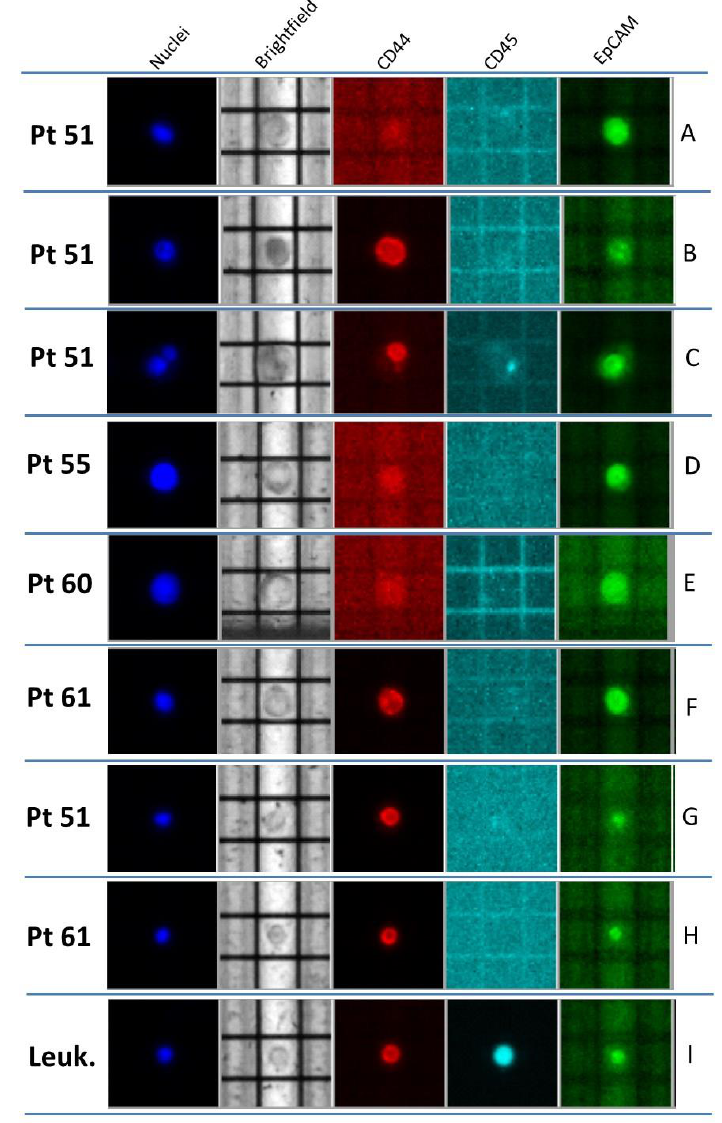
Figure 1. Representative CTCs recovered from the four BC patients enrolled. ( A – F ) Classical CTCs, identified as round, middle-sized cells; CD45-negative, EpCAM-/CD44-positive or -negative, and Hoechst-positive cells. ( A , D ) EpCAM-positive CTCs; ( B , F ) CD44-positive CTCs; ( C ) heterogeneous CTC cluster (composed of one EpCAM-positive cell and one CD44-positive cell); ( E ) EpCAM- and CD44-negative CTC. ( G , H ) “Non-conventional” CTCs, identified as small-sized CD45-negative and CD44-positive cells; ( I ) example of leukocyte (CD45-positive and, very often, CD44-positive cells).